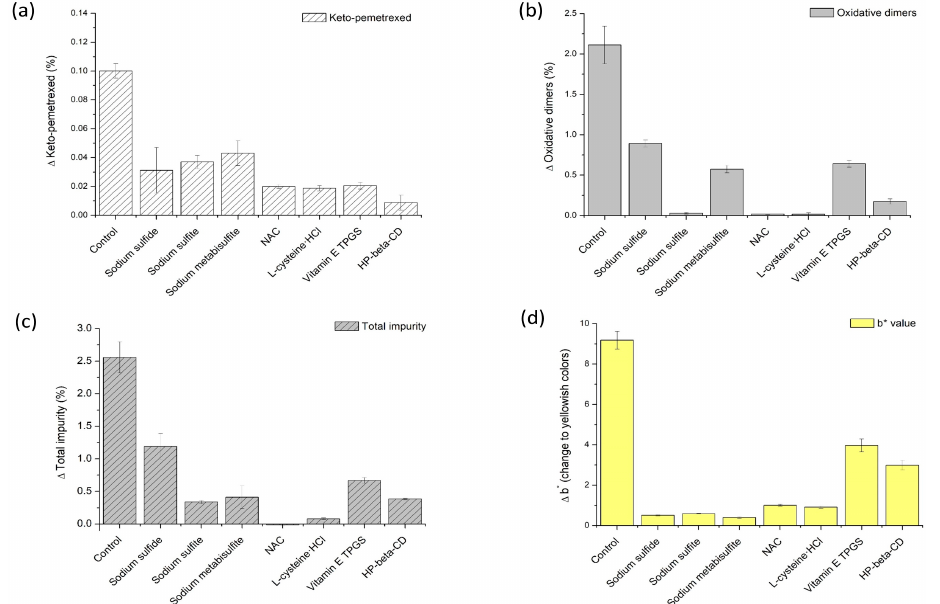
Table 4. Relative retention time (RRT) of pemetrexed’s degradation products.